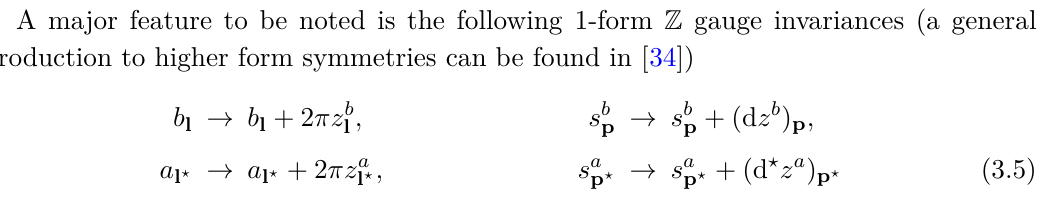
with A through relation A ? = η , where l l ? A l ? + r 0 l ? l ?